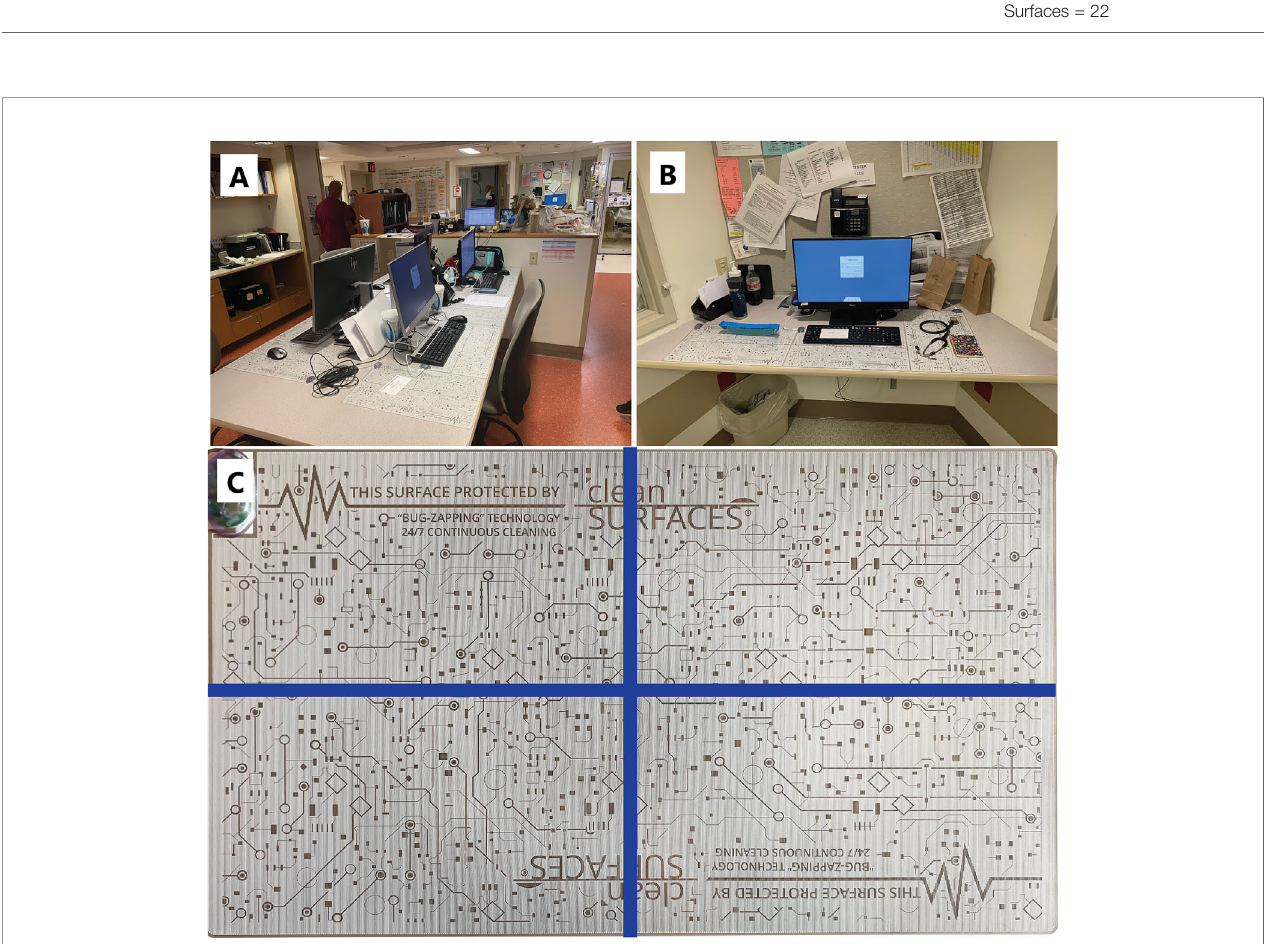
FIGURE 2 | Pictures depicting the placement of cleanSURFACES ® technology around the ICU. (A) Central nurse ’ s workstation for the ICU with cleanSURFACES ® in place on the work area of each of the 4 stations, (B) placement of cleanSURFACES ® in alcove workstations between test rooms, (C) division of a cleanSURFACES ® product into 4 quadrants for sampling on different days in the post-installation period of the study.